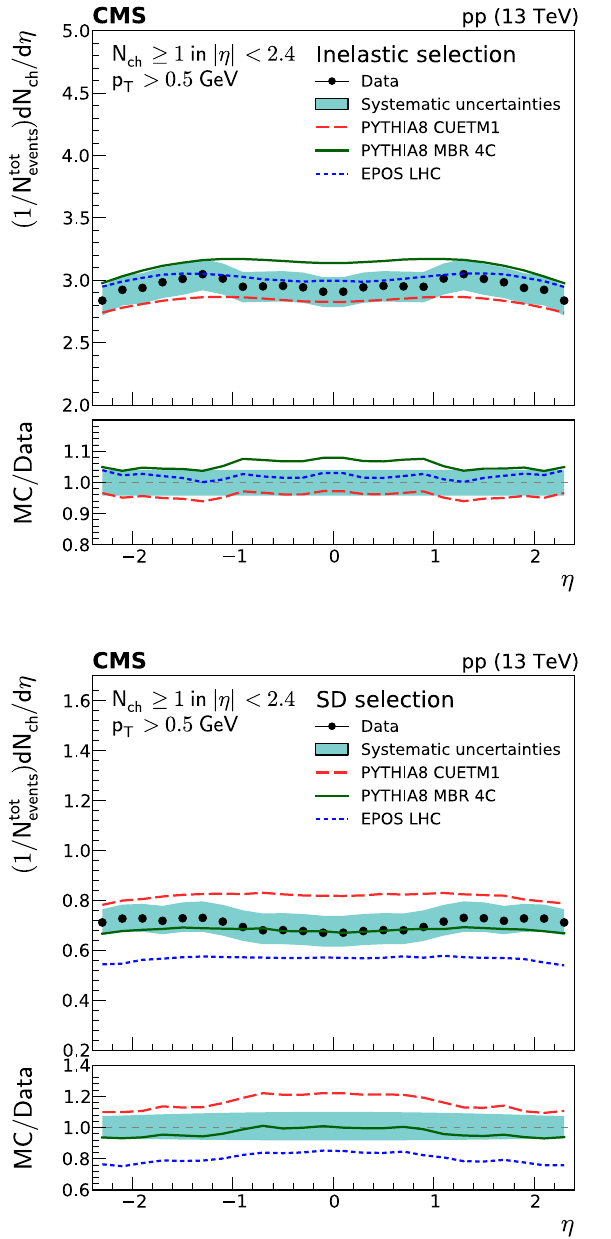
Fig. 2 Charged particle pseudorapidity densities averaged over both positive and negative η ranges. Top to bottom, left to right: inelas- tic, NSD-, SD-, and SD-One-Side enhanced event samples. The mea- surements are compared to the predictions of the pythia 8 cuetm1 (long dashes), pythia 8 mbr4c (continuous line), and epos LHC (short